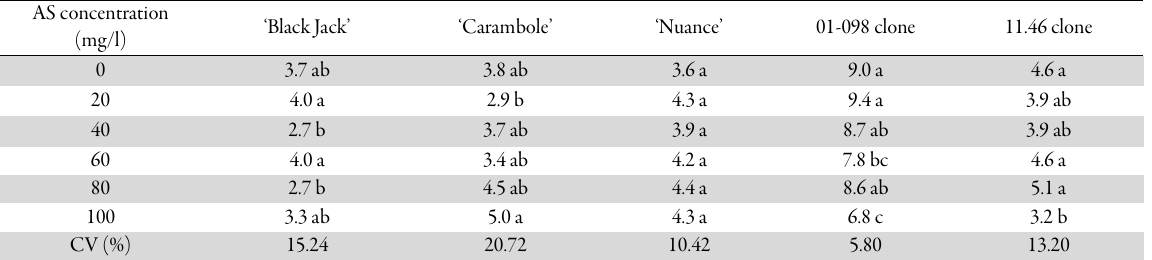
Table 5. Interaction effect of responses of varieties-clones and different concentrations of adenine sulphate on number of shoots produced per shoot